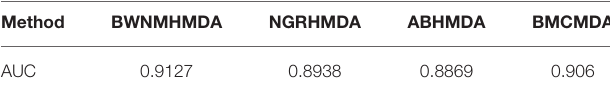
TABLE 3 | AUCs achieved by BWNMHMDA, NGRHMDA, ABHMDA, and BMCMDA in LOOCV separately.